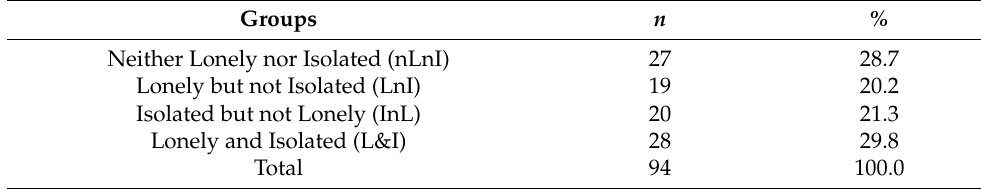
Table 2. Social Isolation and Loneliness